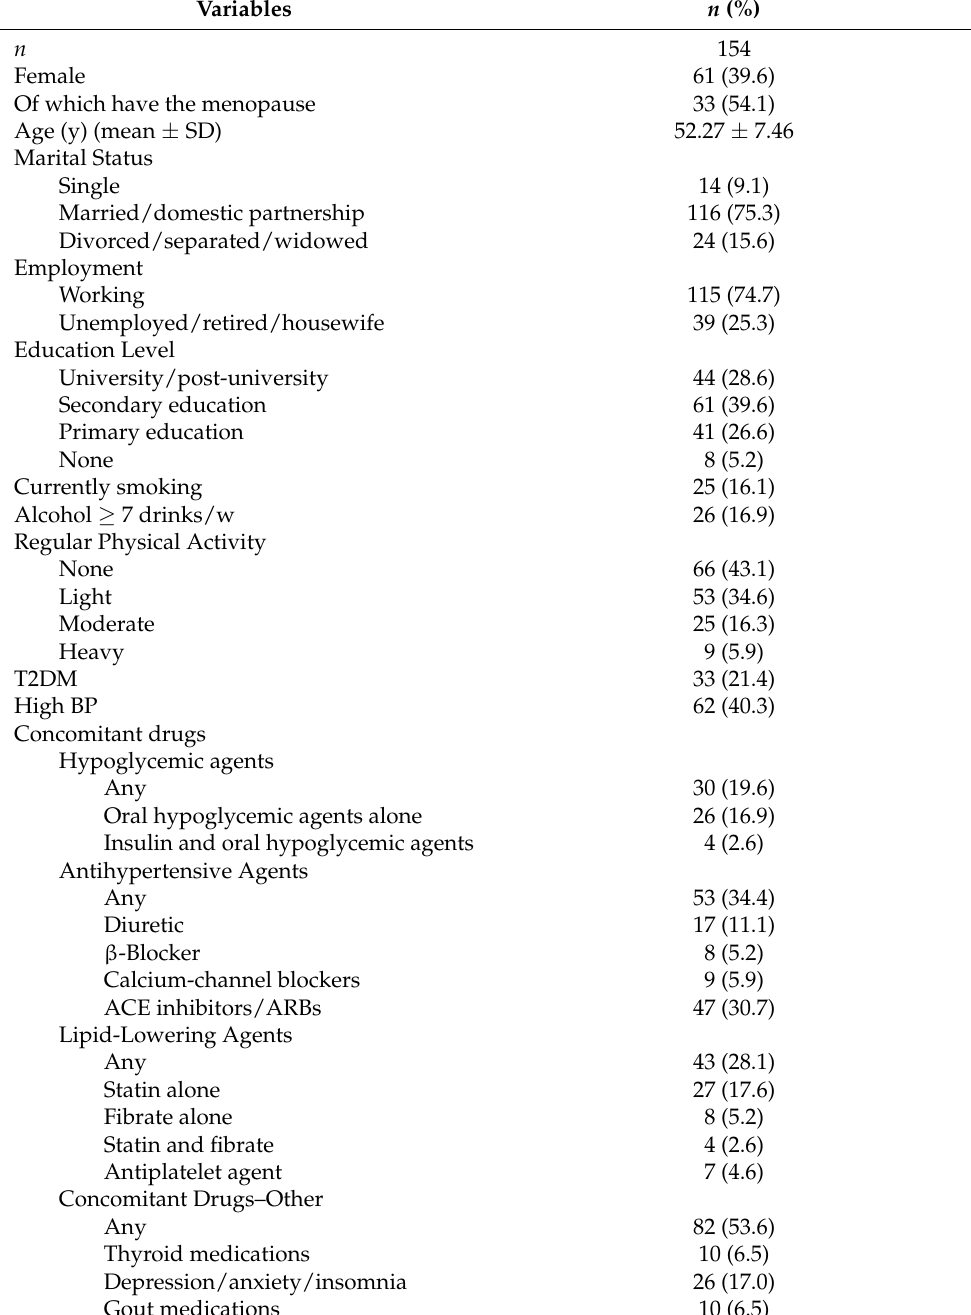
Table 1. Characteristics of the study